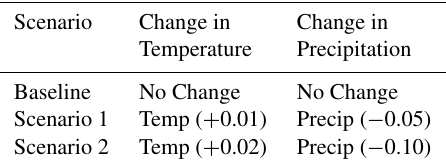
Figure 3. Mean monthly rainfall and temperature relationship for scenario 1 from 1988 to 2019 in